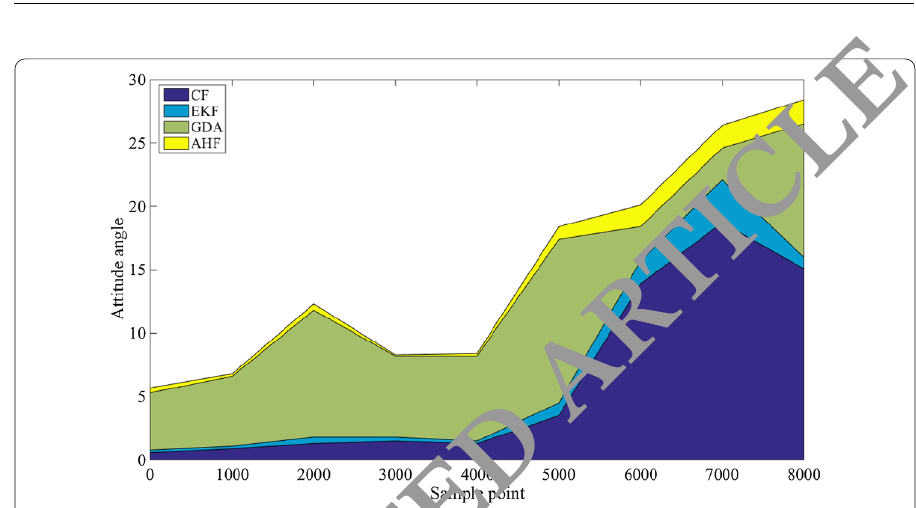
Fig. 5 Different algorithm attitude calculation under acceleration interference